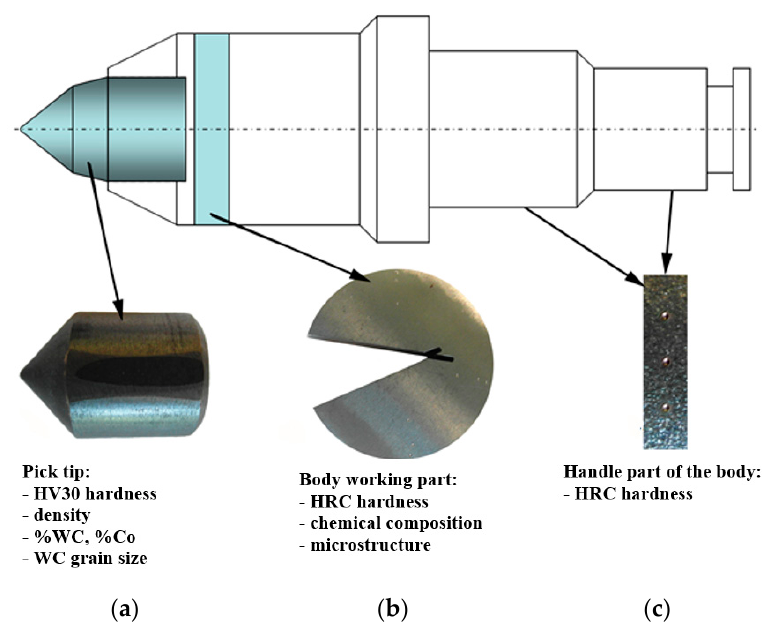
Figure 7. Conical pick with measurement points marked: ( a ) measurement of tip parameters; ( b ) measurement of working part parameters; and ( c ) measurement of gripping part parameters [28,29].